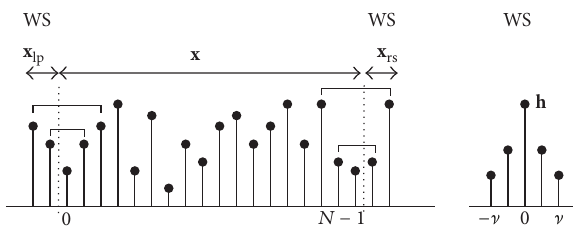
Figure 2: Symmetries in x and h to be used in DCT1-based systems (𝑁 ≫ (2 ] + 1))